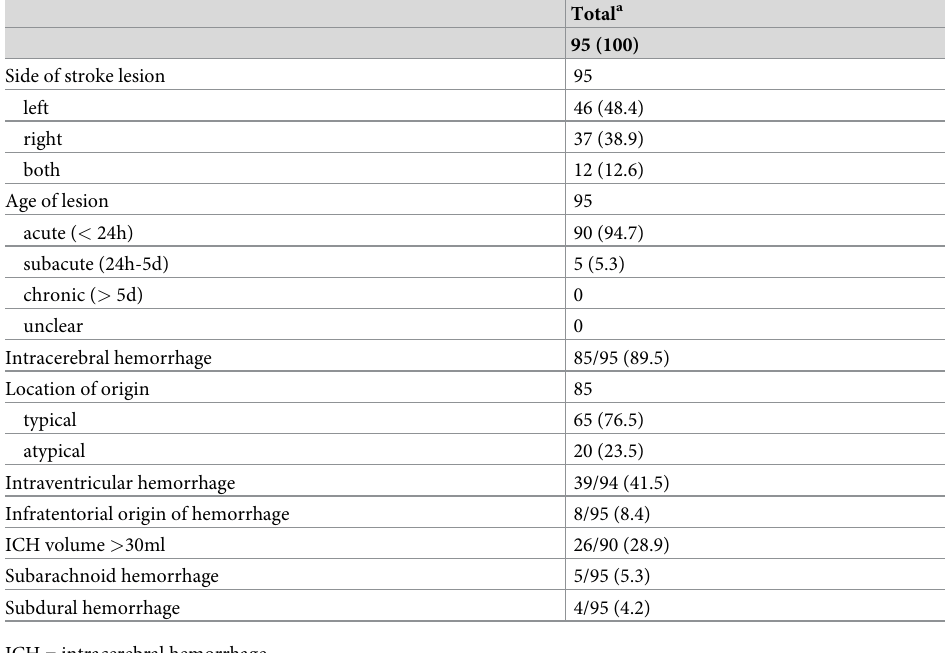
Table 3. Imaging characteristics of patients with hemorrhagic